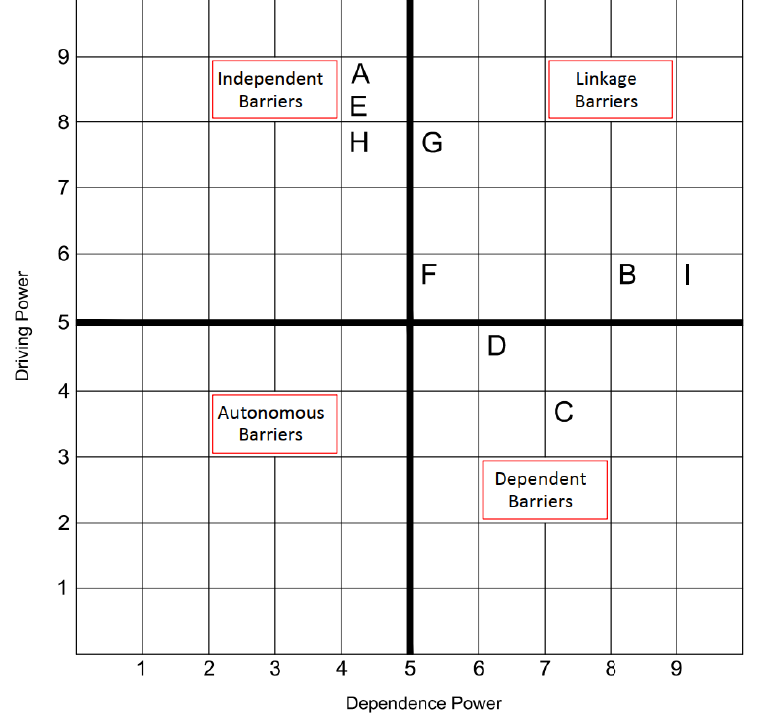
Figure 7. Driving power-dependence diagram for the barriers to climate change adaptation.